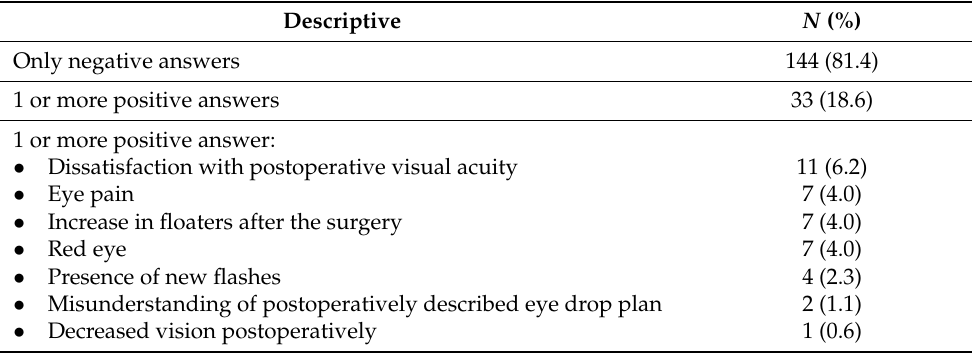
Table 3. Incidence of answers to the questions.